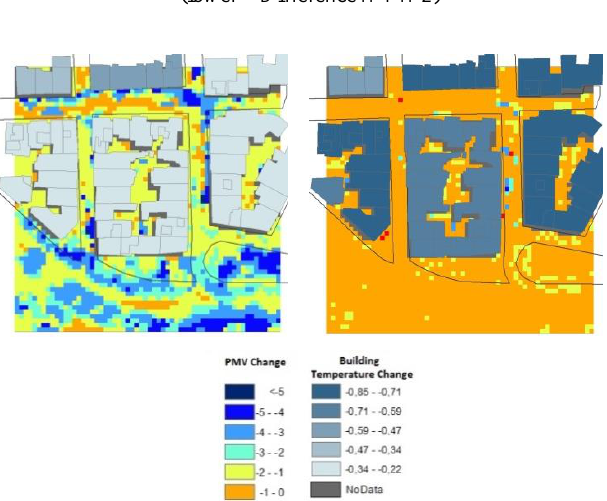
Figure 9: Distribution of differences in thermal comfort values for the height of 0.4 m from the ground (mean height for human motion) (left side – Difference M1-M3), (right side - Difference